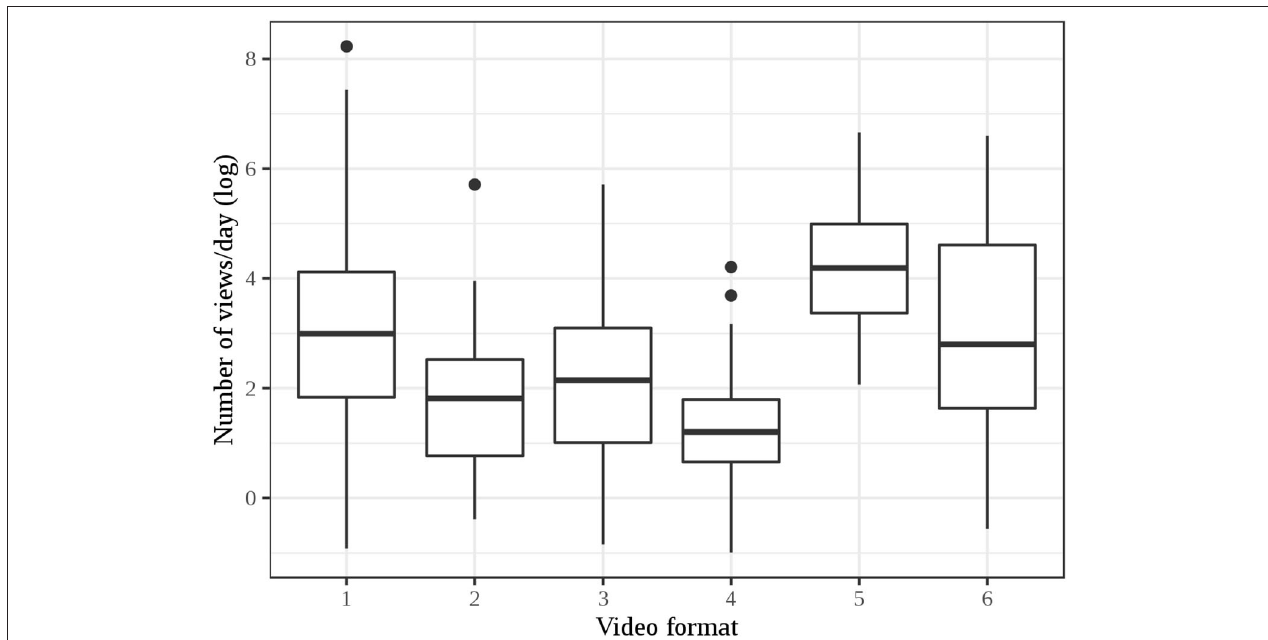
FIGURE 2 | Number of views per day (log) x video format (dots refer to